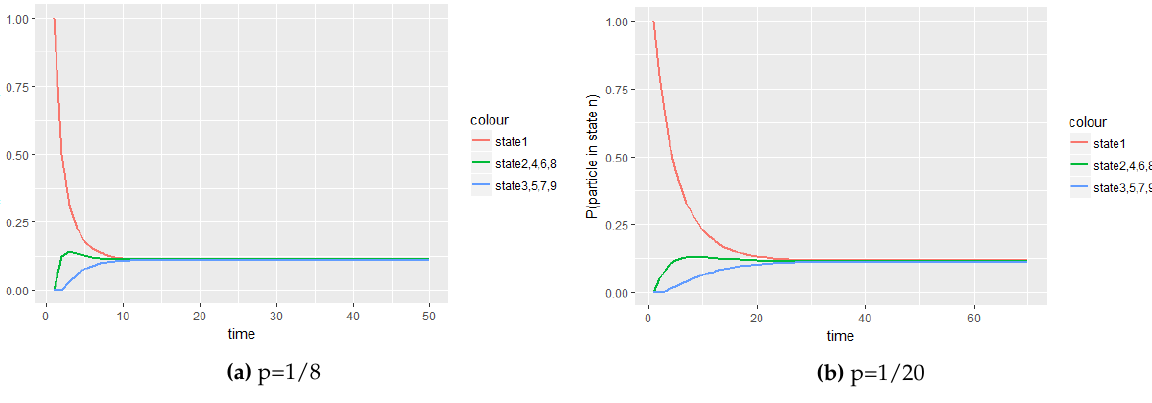
Figure 12. The panel of graphs to represent transitional probabilities against time interval of a transition matrix P with starting point at the central cell with with initial probability vector P 0 figures state 2, 4, 6, and 8 overlap to form a new state while state 3, 5, 7 and 9 overlap because they have the same stochastic behavior to the process.